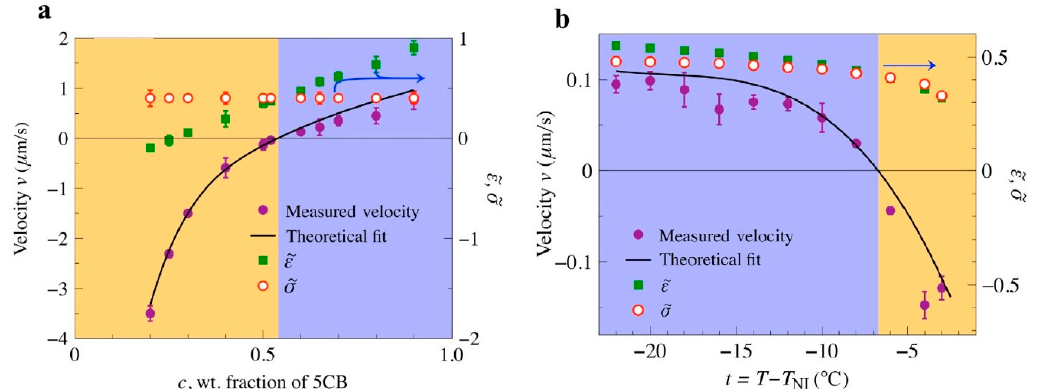
Figure 8. Sign reversal of LCEP velocity by changing anisotropic permittivity of LC 5CB-HNG 715600-100 mixture, demonstrated by Paladugu et al. [36]. ( a ) Dependence of LCEP velocity, anisotropic permittivity and conductivity on the concentration of LC one component, 5CB; (cid:101) ε = σ (cid:107) 1 − 1; ( b ) Dependence of LCEP velocity, anisotropic permittivity and conductivity on temperature. (cid:101) σ = σ ⊥ Adapted with permission from